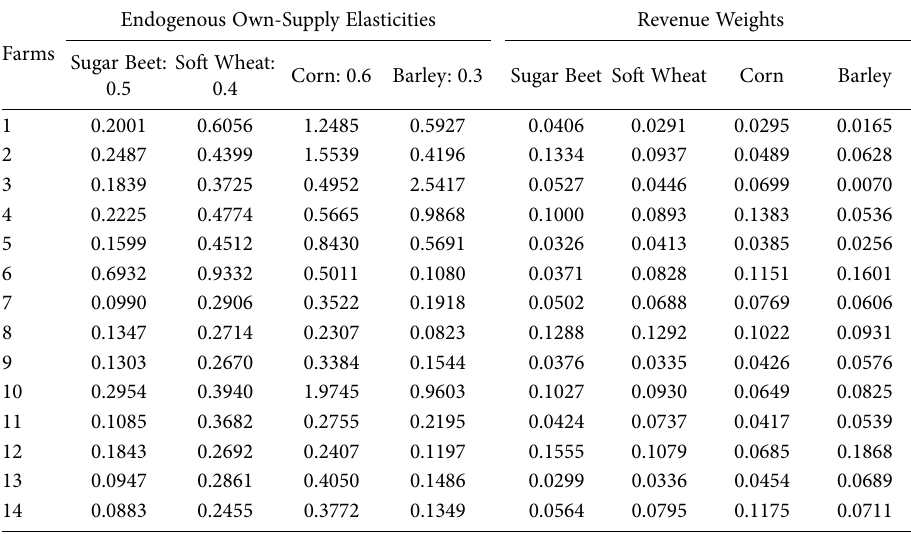
Table 6. Disaggregation/aggregation of the regional, endogenous supply elasticities.